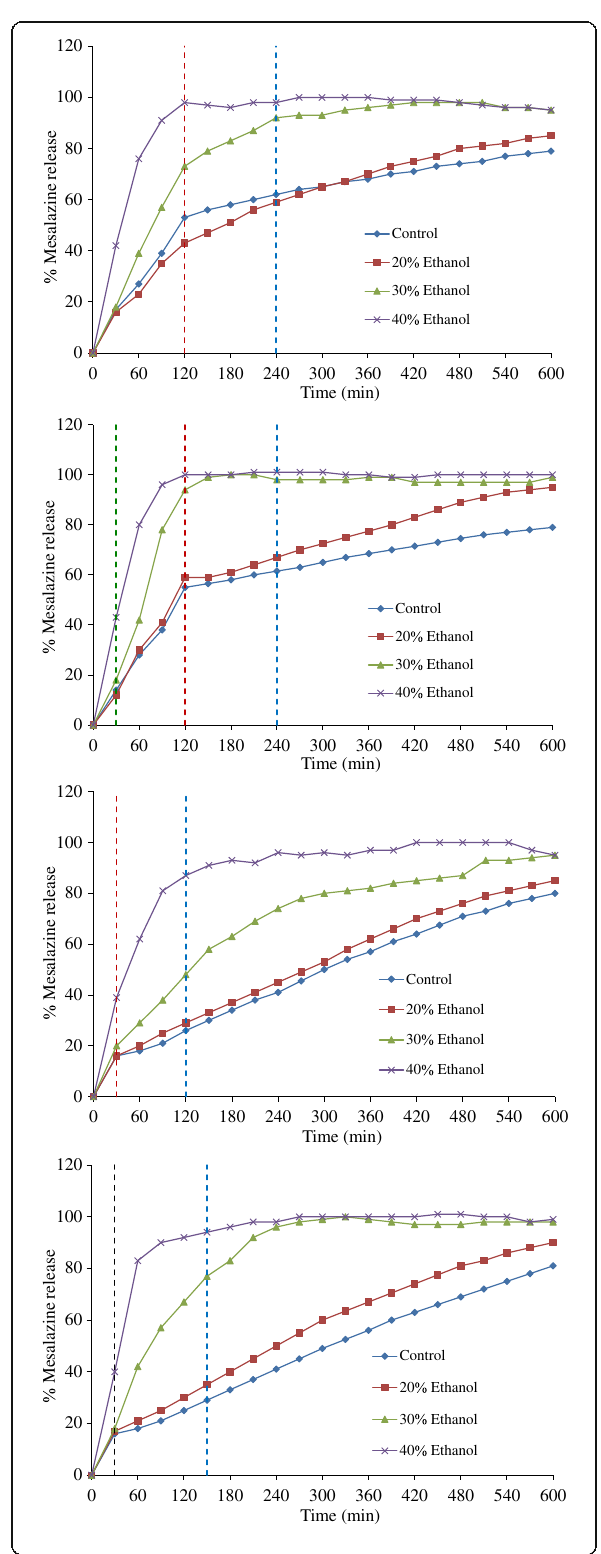
Fig. 16 Dissolution of Pentasa tablets ( red dotted line represents change from 0.1 M HCl with ethanol to pH 6.8 phosphate buffer, blue dotted lin e represents change from pH 6.8 phosphate buffer to pH 7.4 phosphate buffer, green dotted line represents change from 0.1 M HCl with ethanol to 0.1 M HCl with no ethanol, black dotted line represents change from 0.1 M HCl with ethanol to pH 6.8 phosphate buffer where only the first 15 min contains ethanol equivalent to half the concentration in acid) (data from reference (Fadda et al.